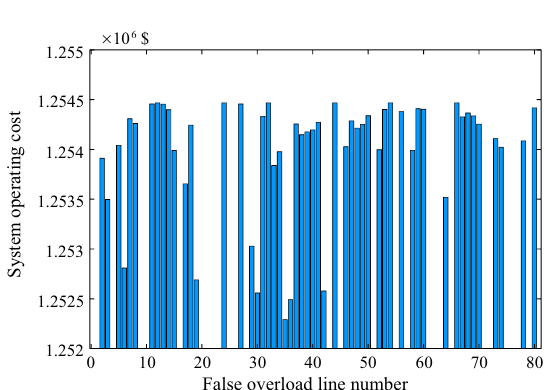
Fig. 7 Operating cost under false overload conditions of the IEEE 57-bus